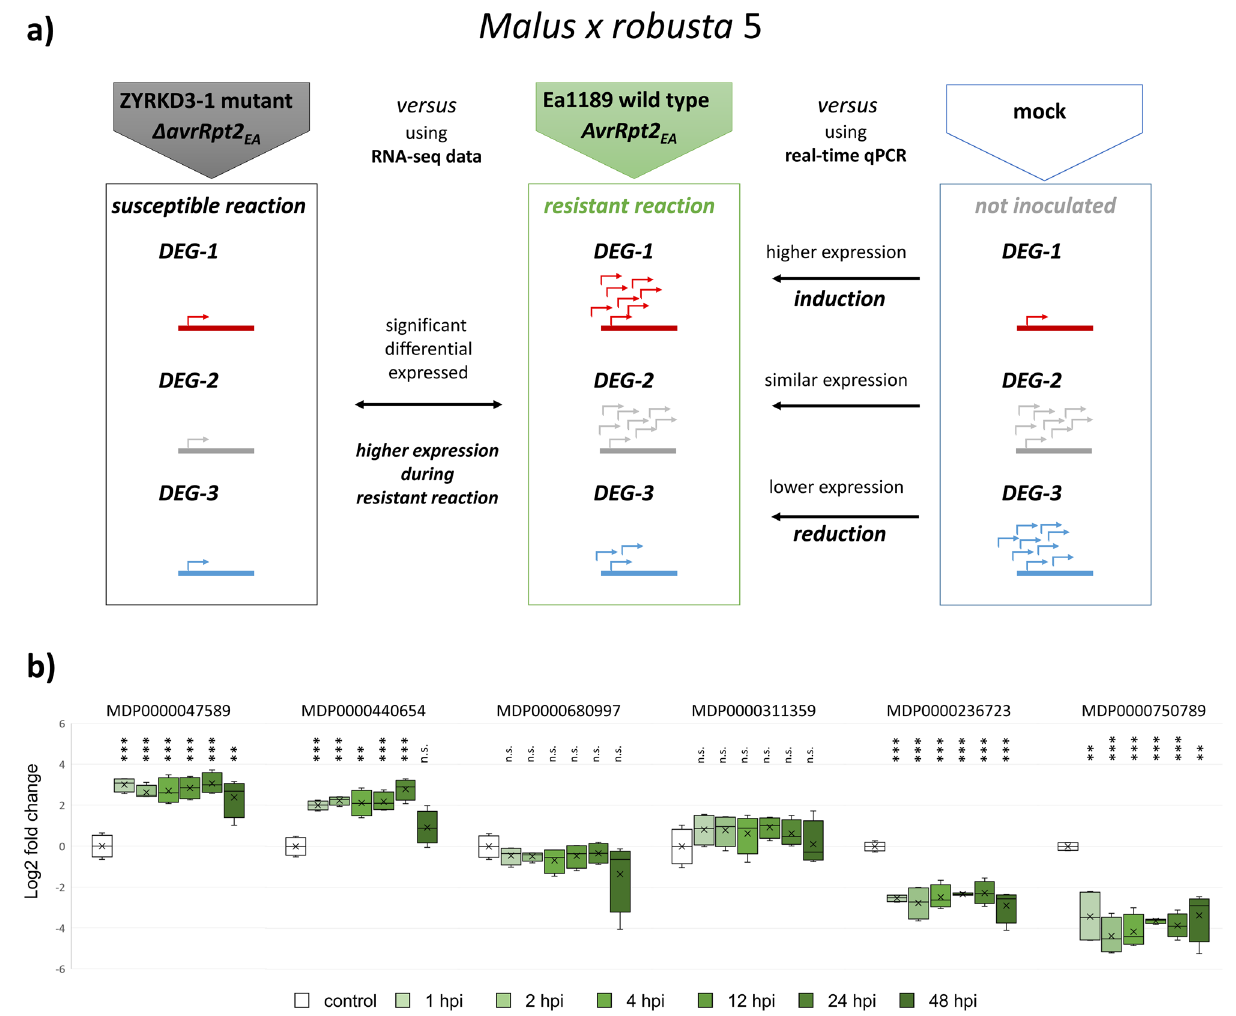
Figure 4. Schematic examples of expression patterns of DEGs with high expression levels during resistant reaction obtained by RNA-seq compared to gene expression determined by qPCR. ( a ) Genome-wide gene expression was measured by RNA-seq to identify genes which are differentially expressed during resistant reaction compared to susceptible reaction. The comparison of expression level between non-inoculated and inoculated condition (avirulent wild type strain Ea1189) reveal the impact on modulation of gene expression (induction, reduction) during resistant response. ( b ) Gene expression of a set of DEGs with an increased expression during resistant reaction was determined by qPCR at 1, 2, 4, 12, 24 and 48 hpi and the fold change was calculated relatively to the non-inoculated control. The log2 fold change is depicted in the box plot